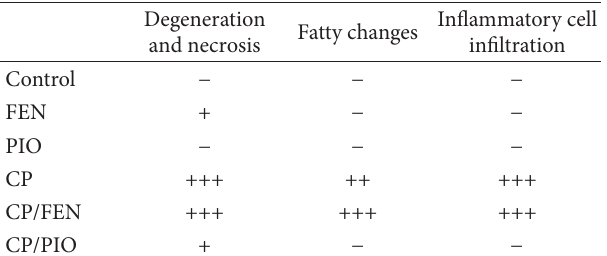
Table 1: Effect of fenofibrate (FEN) and pioglitazone (PIO) on histological findings in cyclophosphamide (CP)-treated rats